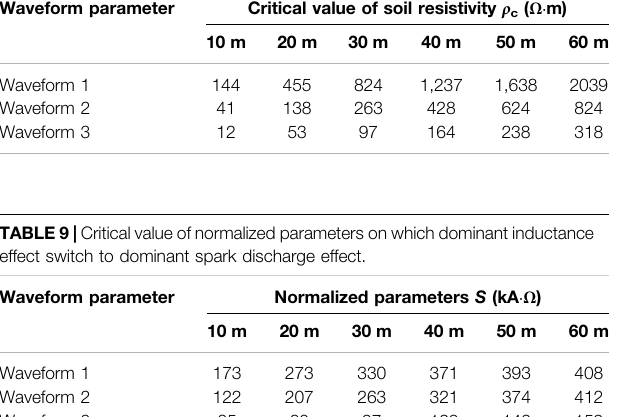
TABLE 8| Soil resistivity critical value on which dominantinductance effect switch to spark discharge effect. Waveform parameter